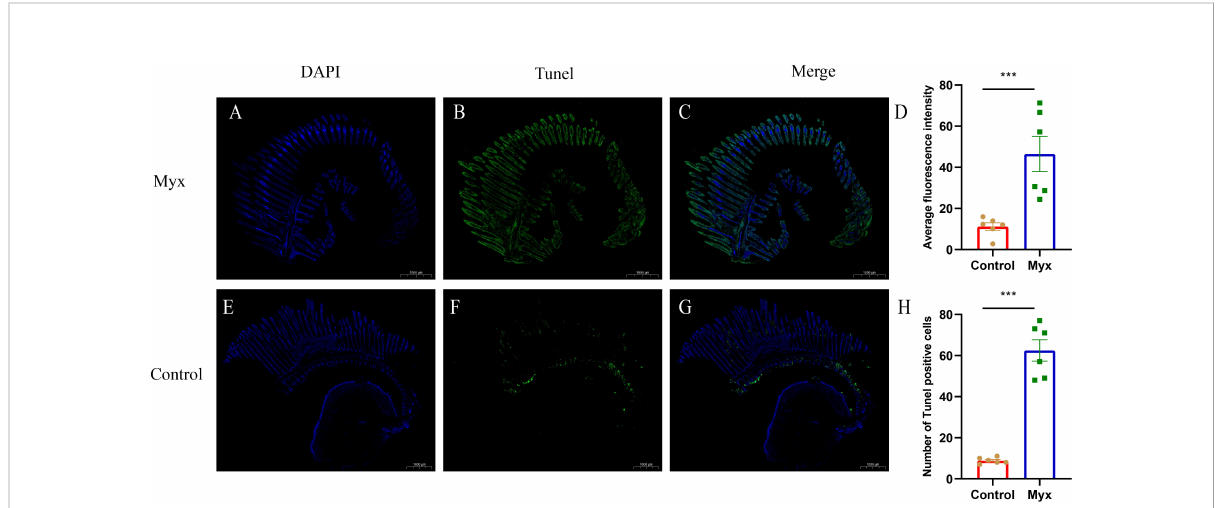
FIGURE 8 TUNEL assays of gills which were stained with DAPI (blue) or fl uorescein-dUTP (green). (A – C) TUNEL assays of gold fi sh in Myx group, Plentiful apoptotic cells appeared on the gill of Myx group. (E – G) TUNEL assays of gold fi sh in control group, very few apoptotic cells presented on the gill of control group. (D) Statistical analysis of mean fl uorescence intensity (2mm 2 ). (H) Statistical analysis of TUNEL positive cells numbers (2mm 2 ). Signi fi cance: P < 0.05 (*), P < 0.01 (**), P < 0.001 (***).